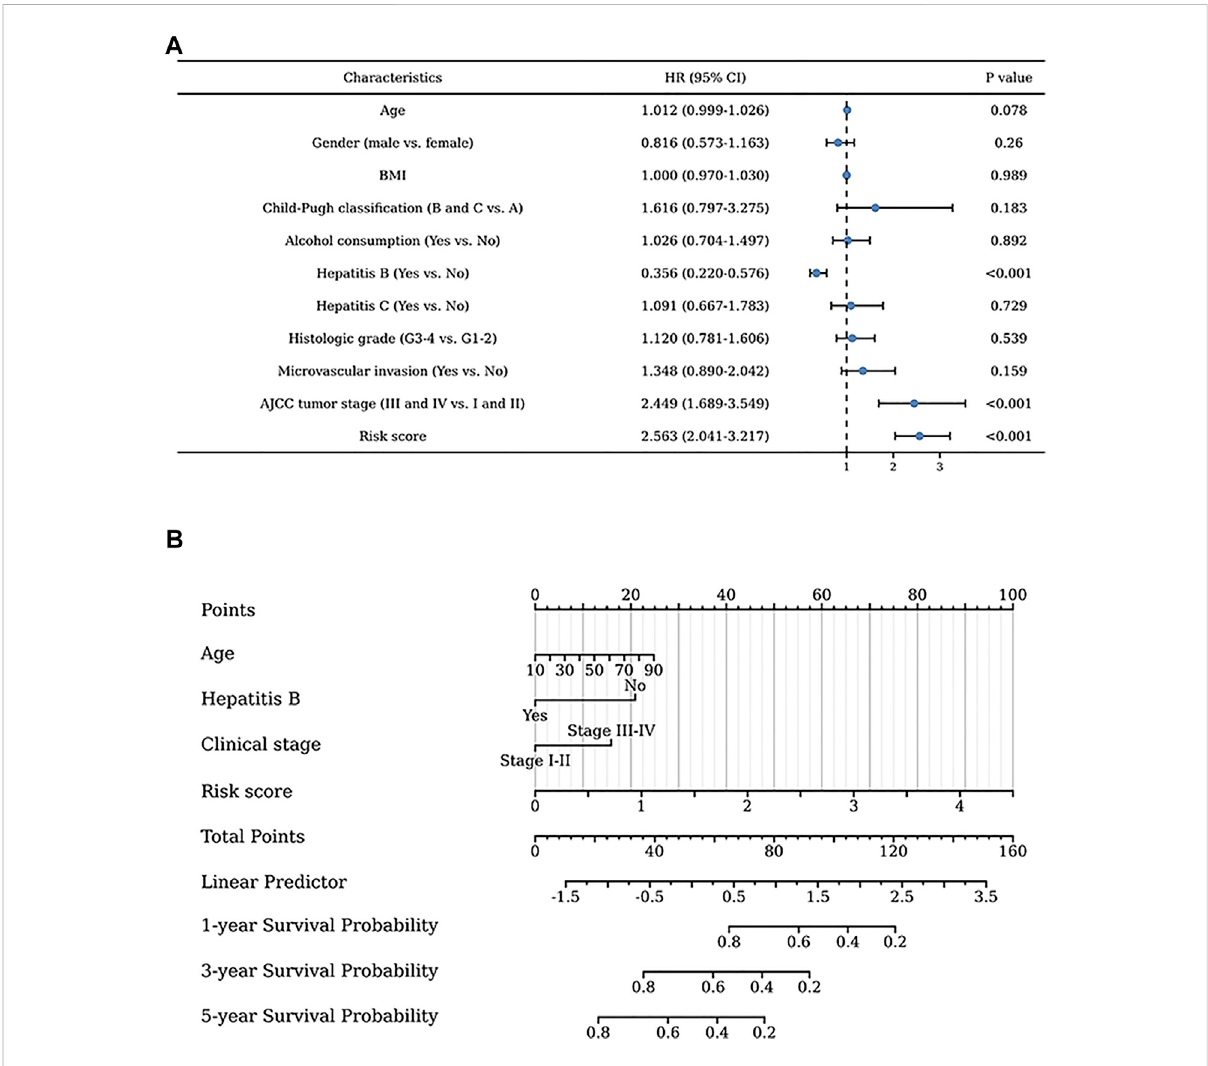
FIGURE 4 Clinical values of the exosome-related lncRNA signature. (A) The univariate regression analysis of clinical factors for the patients ’ prognosis. (B) The nomogram was constructed to further identify the clinical applicability of this risk